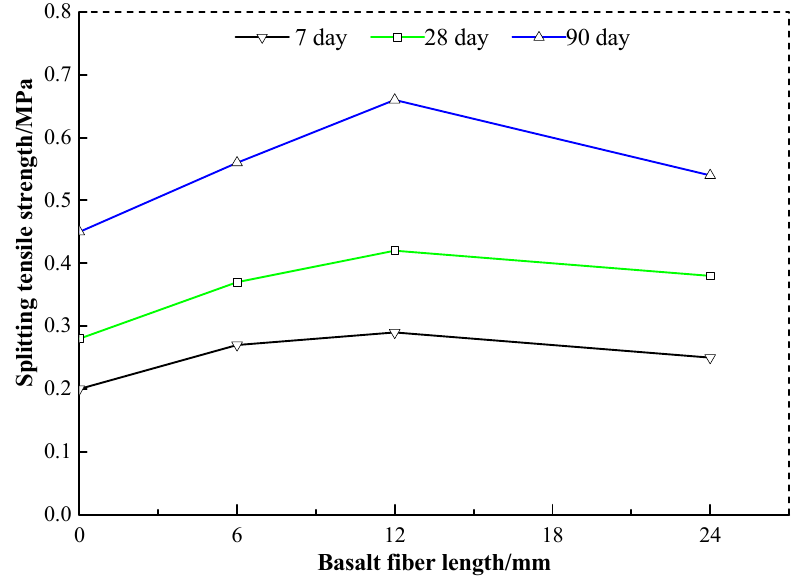
Figure 8. The relations between basalt fiber length and splitting tensile strength.